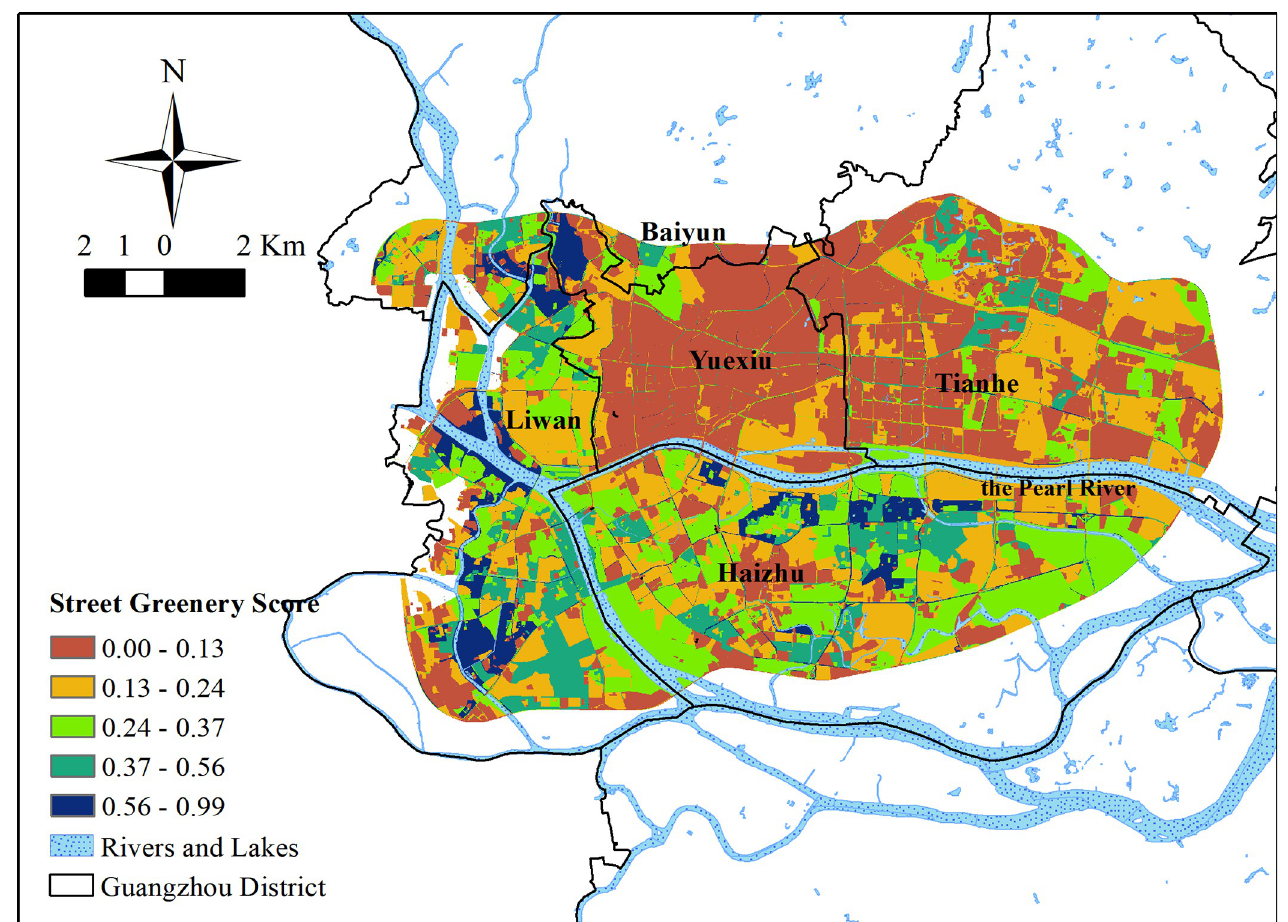
Fig 4. The SGS results in the study